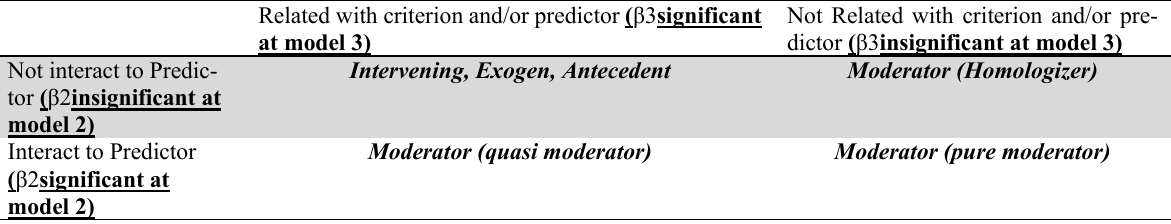
Type of Moderating Variable (Rules of Thumb) Related with criterion and/or predictor ( β 3 significant at model